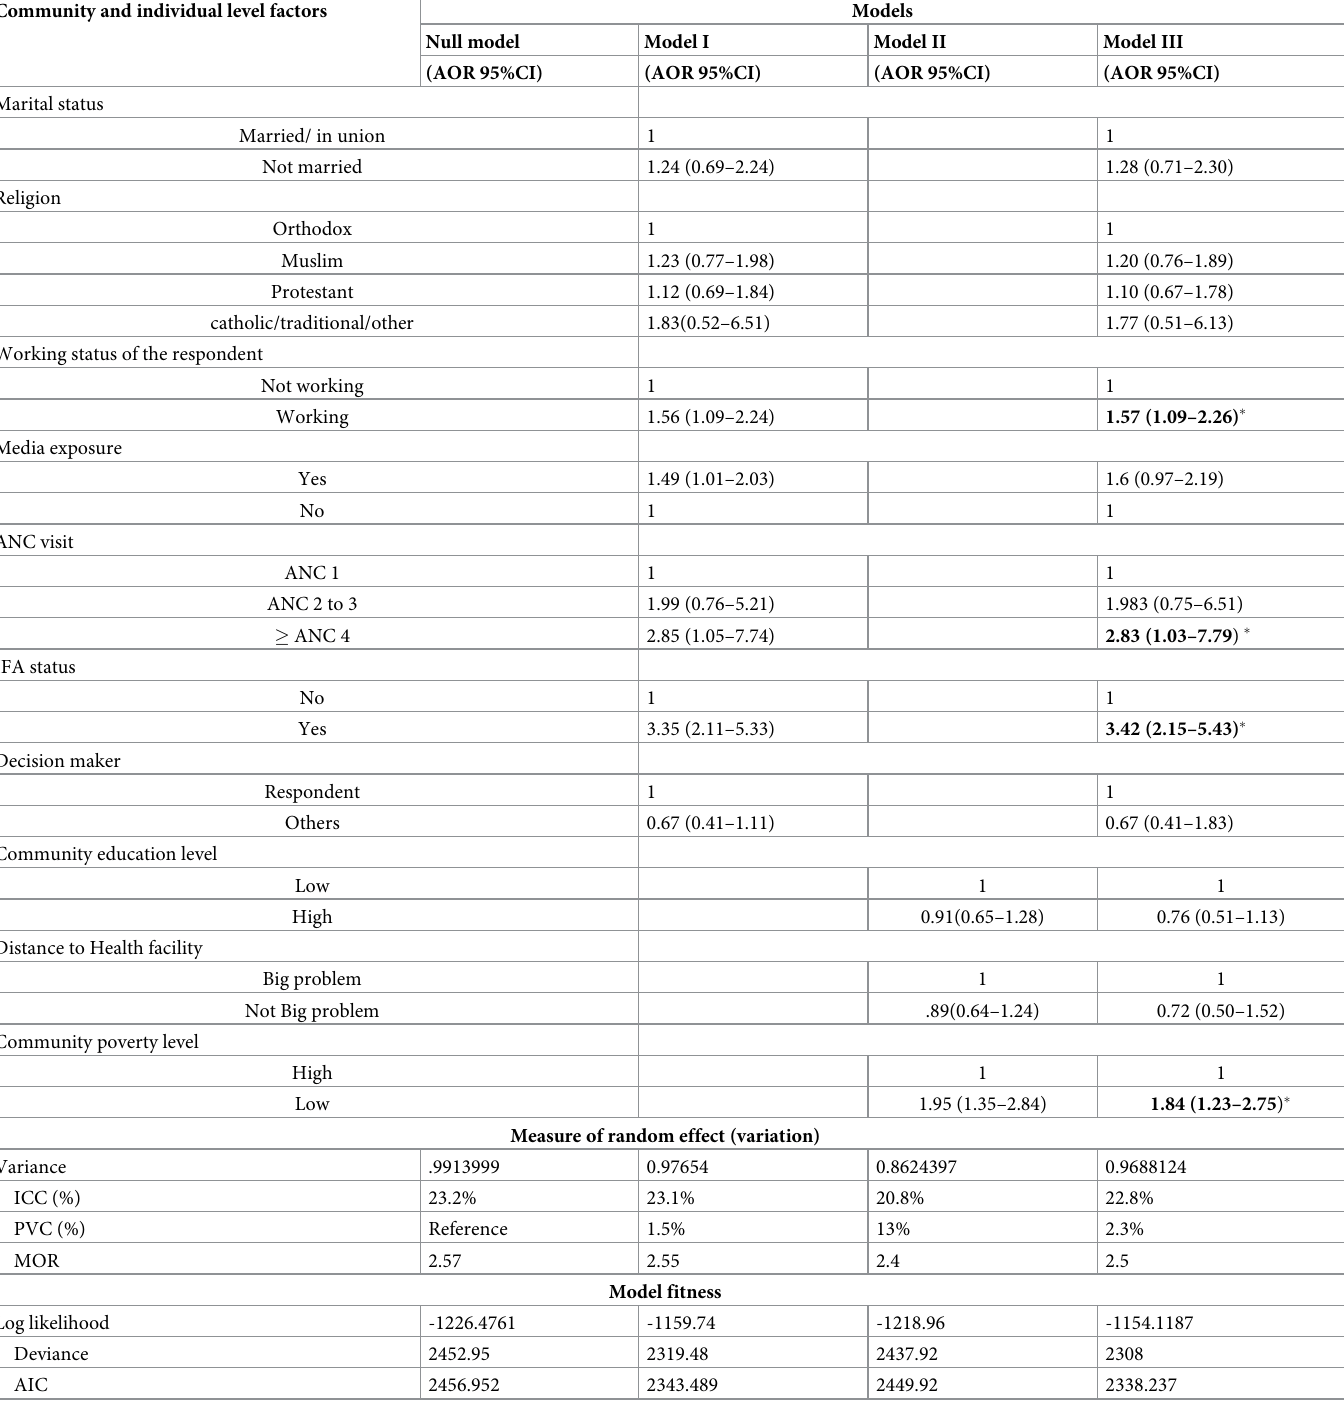
Table 3. Multi-variable multilevel binary logistic regression analysis result of both community and individual level factors associated with utilization of deworming medication in pregnant mothers in Ethiopia, EDHS